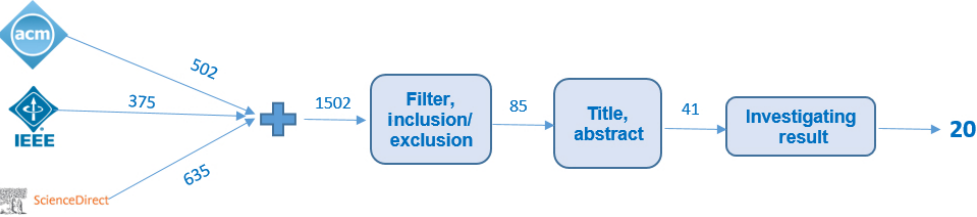
Fig. 4 Selection process for this